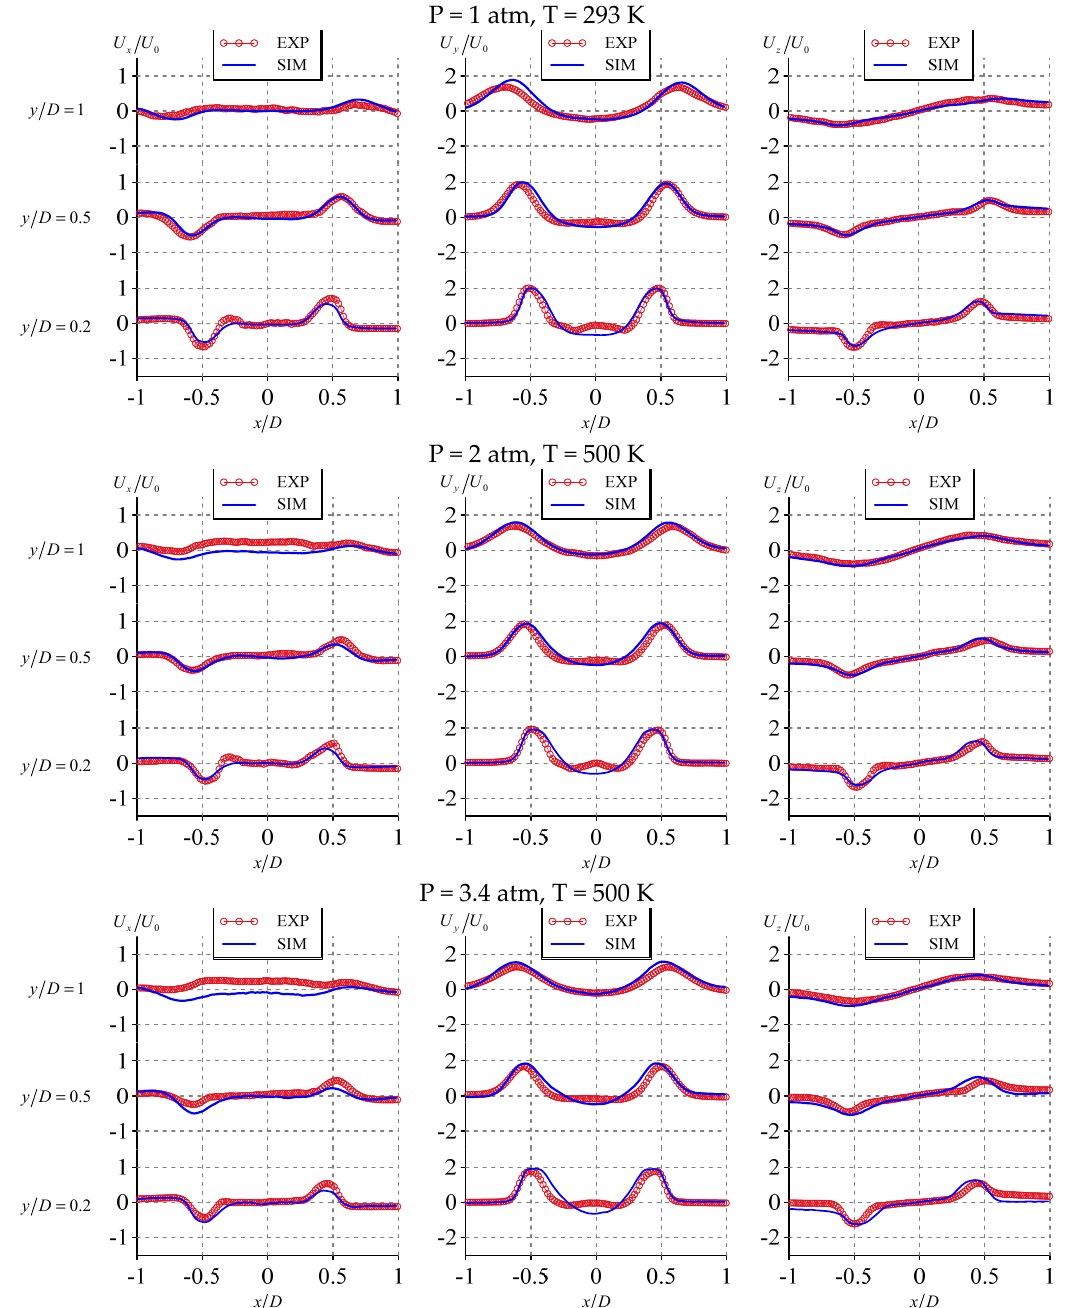
Figure 3. Comparison of the mean velocity profiles measured by PIV and modelled by LES: radial component in the left column, axial component in the middle column, and azimuthal component in the right column.